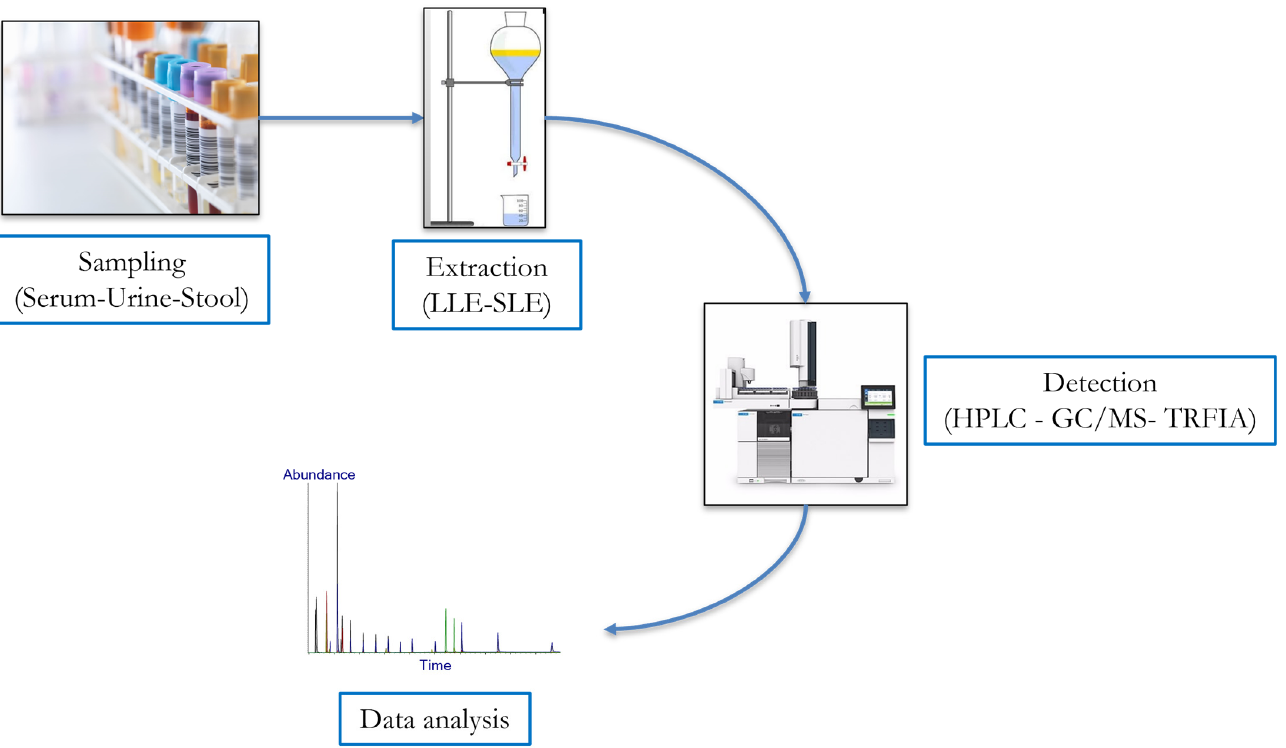
Figure 3. Experimental workflow for qualitative and quantitative analysis of lignans. LLE: liquid- liquid extraction, SLE: solid-liquid extraction, HPLC: high-performance liquid chromatography, GC/MS: gas chromatography mass spectrometry, TRFIA: time-resolved